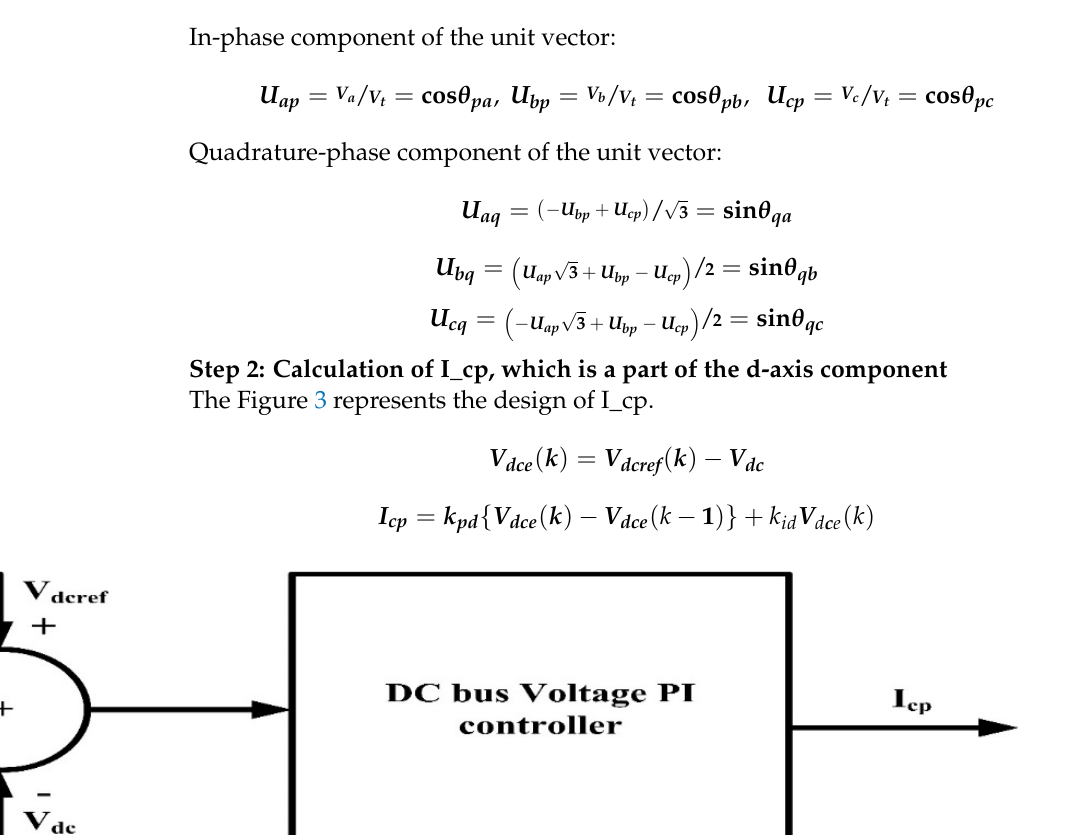
Figure 2. In-phase and Q-phase of the unit vector.